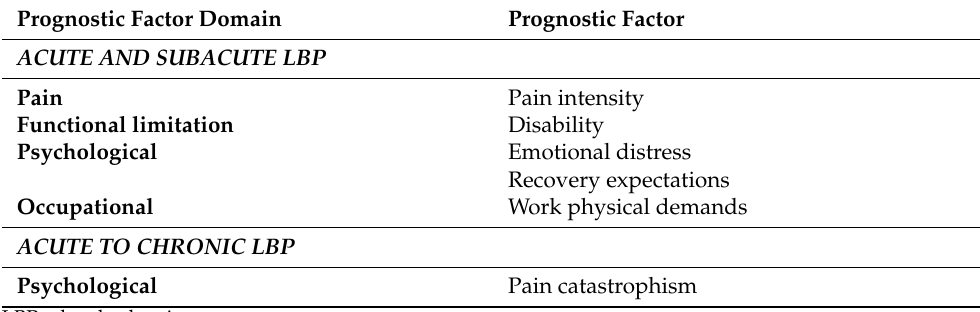
Table 4. Predictor variables of an explanatory model in patients with